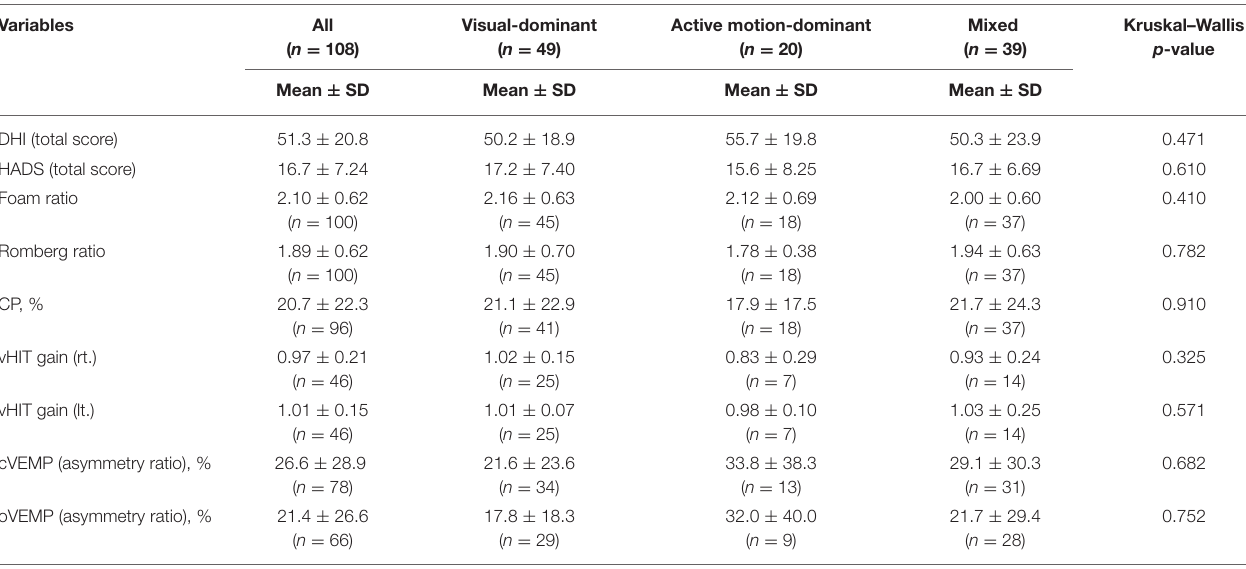
TABLE 5 | Clinical characteristics of the three